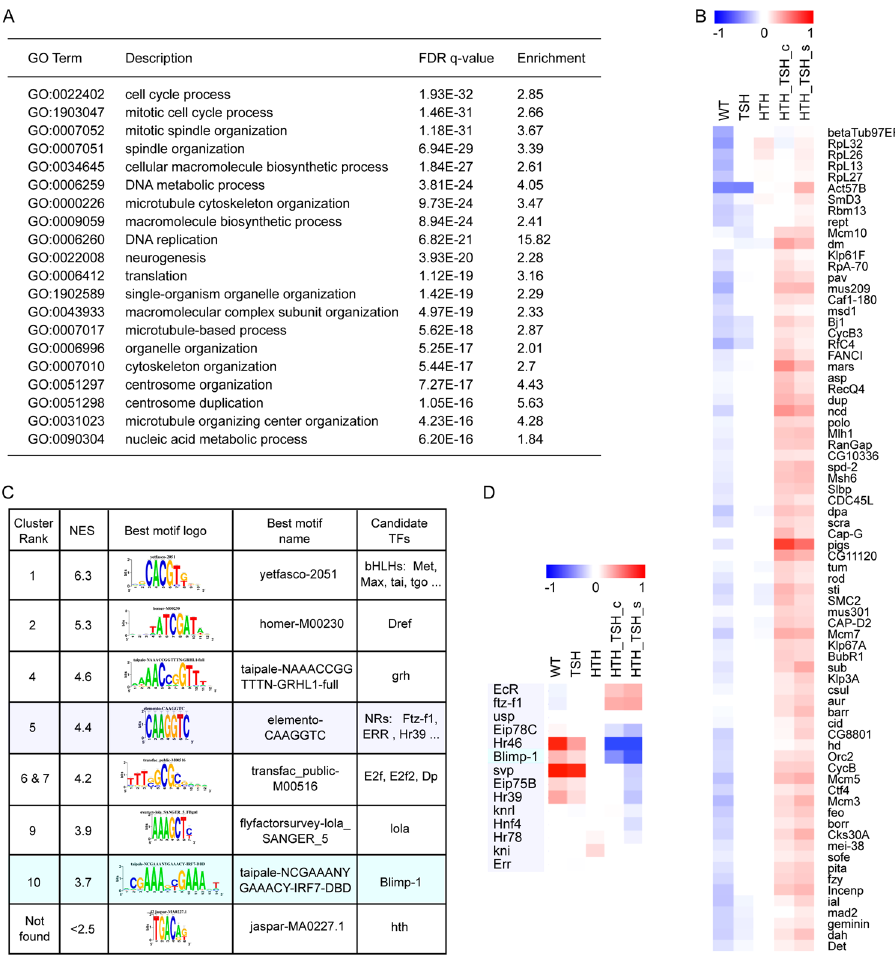
Figure 2. Transcriptomic profile of of hth + tsh cells. ( A ) Gene Ontology enrichment of genes up-regulated in hth + tsh compared to control eye discs (EA). Analysis performed by GOrilla 97 on a ranked list of genes sorted by (signed) − log10(p-value). The sign indicates that up-regulated genes are on top (logFC > 0) and down-regulated genes (logFC < 0) are on the bottom of the list. ( B ) Heatmap with row-normalized expression values of the most significantly up-regulated cell-cycle related genes. ( C ) Motif enrichment on the up-regulated genes (770 genes, selected as the “leading edge” of the GOrilla analysis for cell cycle enrichment). Enrichment analysis is performed by i-cisTarget 33 and enriched motifs are clustered within i-cisTarget using STAMP 103 . NES = Normalized Enrichment Score ( > 2.5 is significant). The Hth motif was not found enriched. ( D ) Heat map of expression profiles of motif related Nuclear Receptor genes and Blimp-1, showing strongest up- regulation of EcR and ftz-f1, and strongest down-regulation of Hr46 and